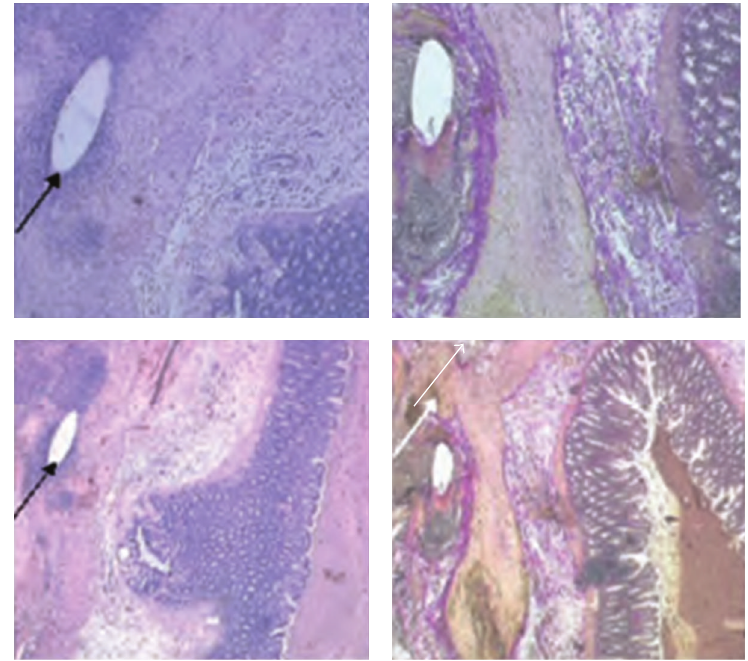
Figure 3: For histologic examinations, the region of the anastomosis was dissected 2cm proximal and distal of the anastomosis. HE stains and von Gieson stains were done to evaluate the anastomotic healing. The black arrow marks the suture material, and the white arrow marks the